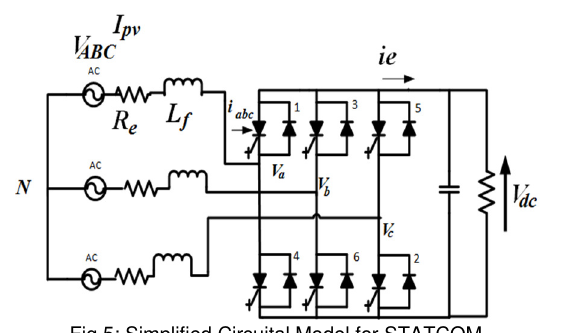
Fig 5: Simplified Circuital Model for STATCOM